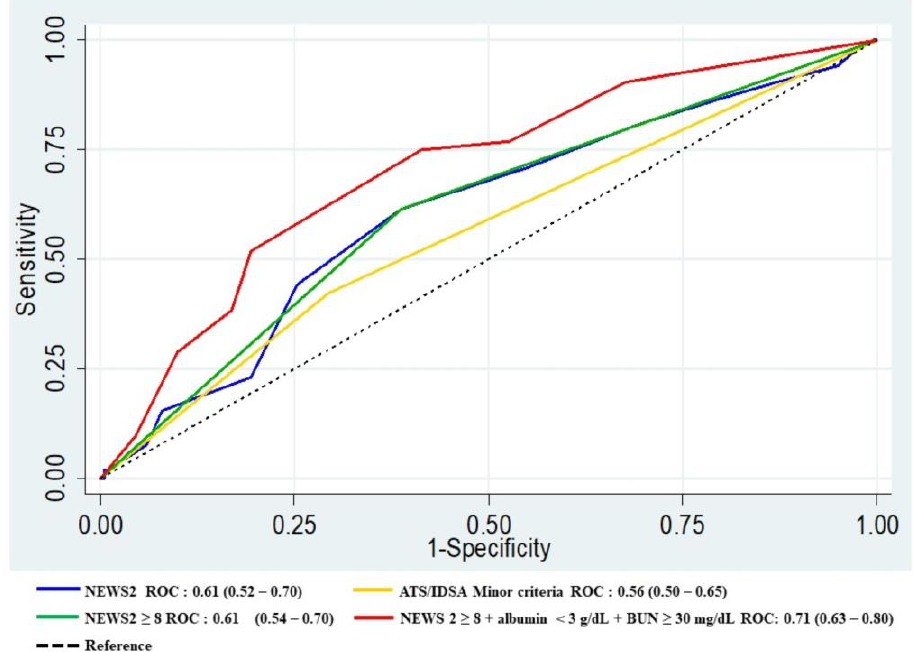
Figure 1. ROC curve for predicting early progression to severe CAP: comparisons between ATS/IDSA minor criteria, NEWS2, NEWS2 ≥ 8, and NEWS 2 ≥ 8 + Albumin < 3 g/dL + BUN ≥ 30 mg/dL. Table 3. Sensitivity of NEWS2 at Initial Admission to Predict Early Progression of Pneumonia.